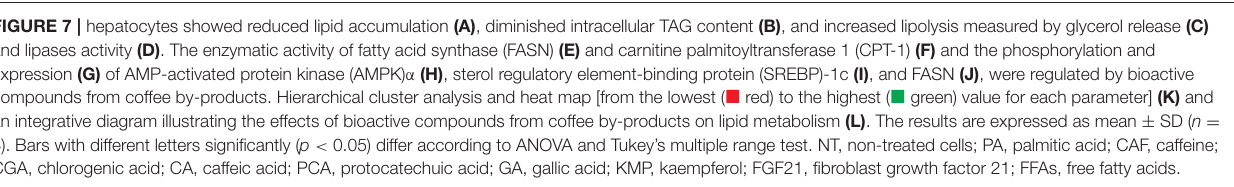
FIGURE 7 | hepatocytes showed reduced lipid accumulation (A) , diminished intracellular TAG content (B) , and increased lipolysis measured by glycerol release (C) and lipases activity (D) . The enzymatic activity of fatty acid synthase (FASN) (E) and carnitine palmitoyltransferase 1 (CPT-1) (F) and the phosphorylation and expression (G) of AMP-activated protein kinase (AMPK) α (H) , sterol regulatory element-binding protein (SREBP)-1c (I) , and FASN (J) , were regulated by bioactive compounds from coffee by-products. Hierarchical cluster analysis and heat map [from the lowest ( (cid:4) red) to the highest ( (cid:4) green) value for each parameter] (K) and an integrative diagram illustrating the effects of bioactive compounds from coffee by-products on lipid metabolism (L) . The results are expressed as mean ± SD ( n = 3). Bars with different letters significantly ( p < 0.05) differ according to ANOVA and Tukey’s multiple range test. NT, non-treated cells; PA, palmitic acid; CAF,